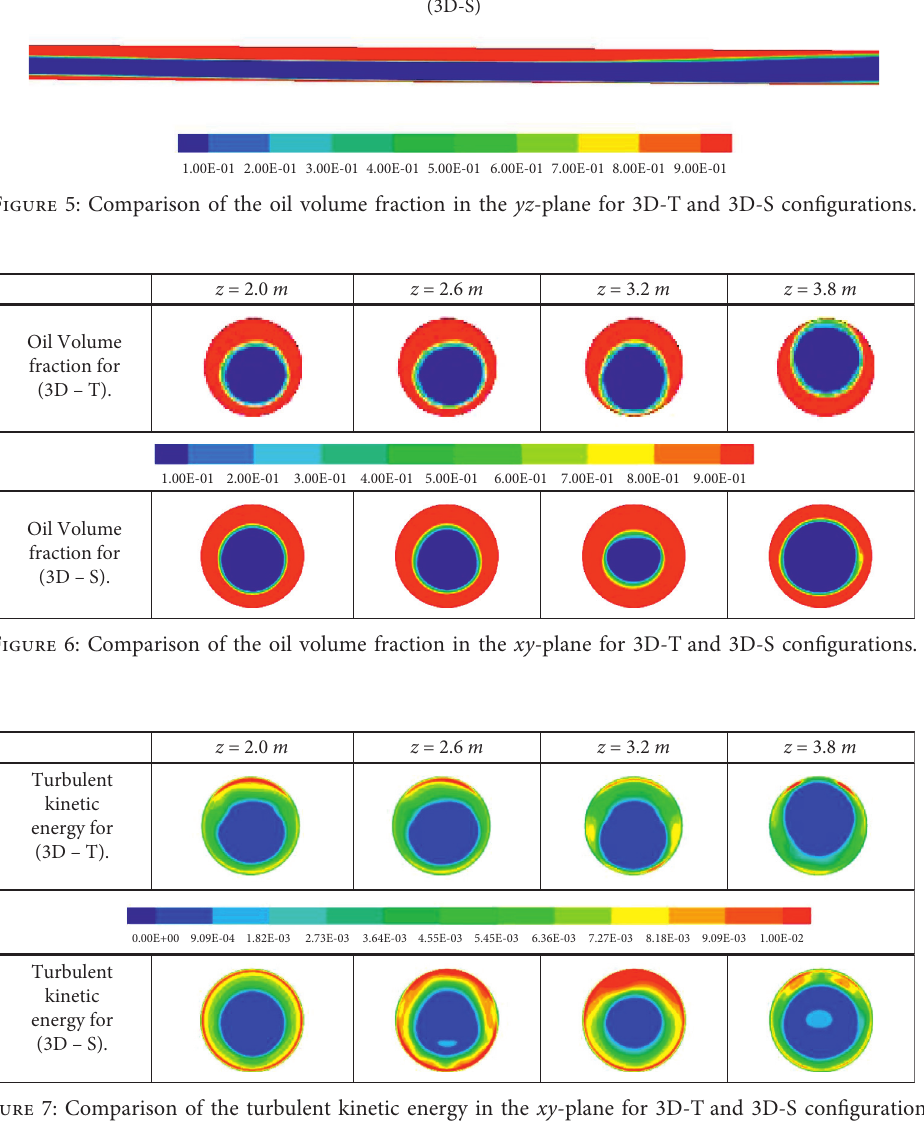
Turbulent kinetic energy for (3D – S). Figure 7: Comparison of the turbulent kinetic energy in the xy -plane for 3D-T and 3D-S